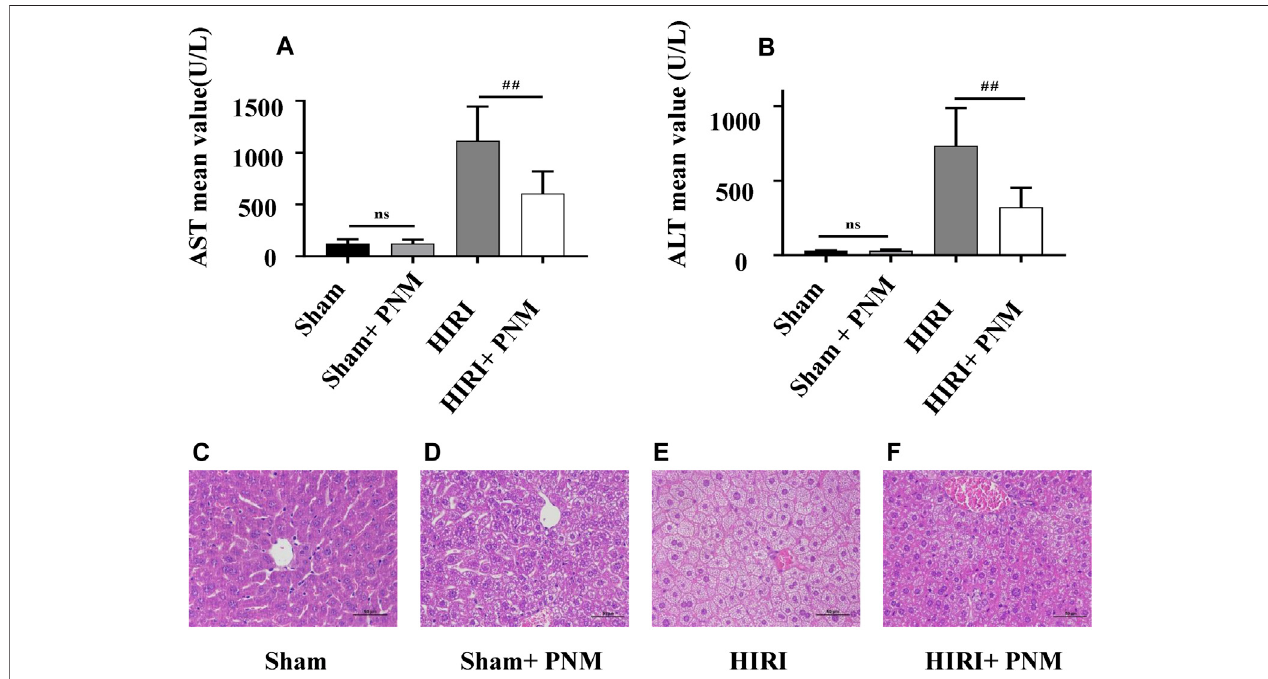
FIGURE2| EffectsofPNMonASTandALTinserumofHIRImice.Figure (A,B) showsthattheexpressionsofASTandALTinserumofmiceintheHIRIgroupwere signi fi cantlyhigherthan thoseinthesham group( p ˂ 0.01),indicatingsuccessful modeling.ComparedwiththeHIRIgroup, theexpressions ofASTandALTintheserum ofmice intheHIRI +PNMgroupweresigni fi cantlydecreased ( ## p ˂ 0.01),indicatingthatPNM hadaprotectiveeffect onHIRI inmice.There wasno signi fi cantdifference inserumASTandALTbetweentheshamandsham+PNMgroups( p > 0.05),indicatingthatPNMdoesnotcausedamagetohealthymice,whichprovesthesafety ofPNM(n (cid:2) 7). (C – F) ResultsofHEstainingexperiment. (C) Themouselivertissuewasintact. (D) Livertissuewaslargelyintact. (E) Livertissueshowedvaryingdegrees of swelling/necrosis, steatosis, in fl ammatory cell in fi ltration, and so on. (F) The pathological changes of mouse liver tissue were improved, indicating that PNM had a protective effect on HIRI mice. The scale is 50 μ m, and the magni fi cation is 400 times.